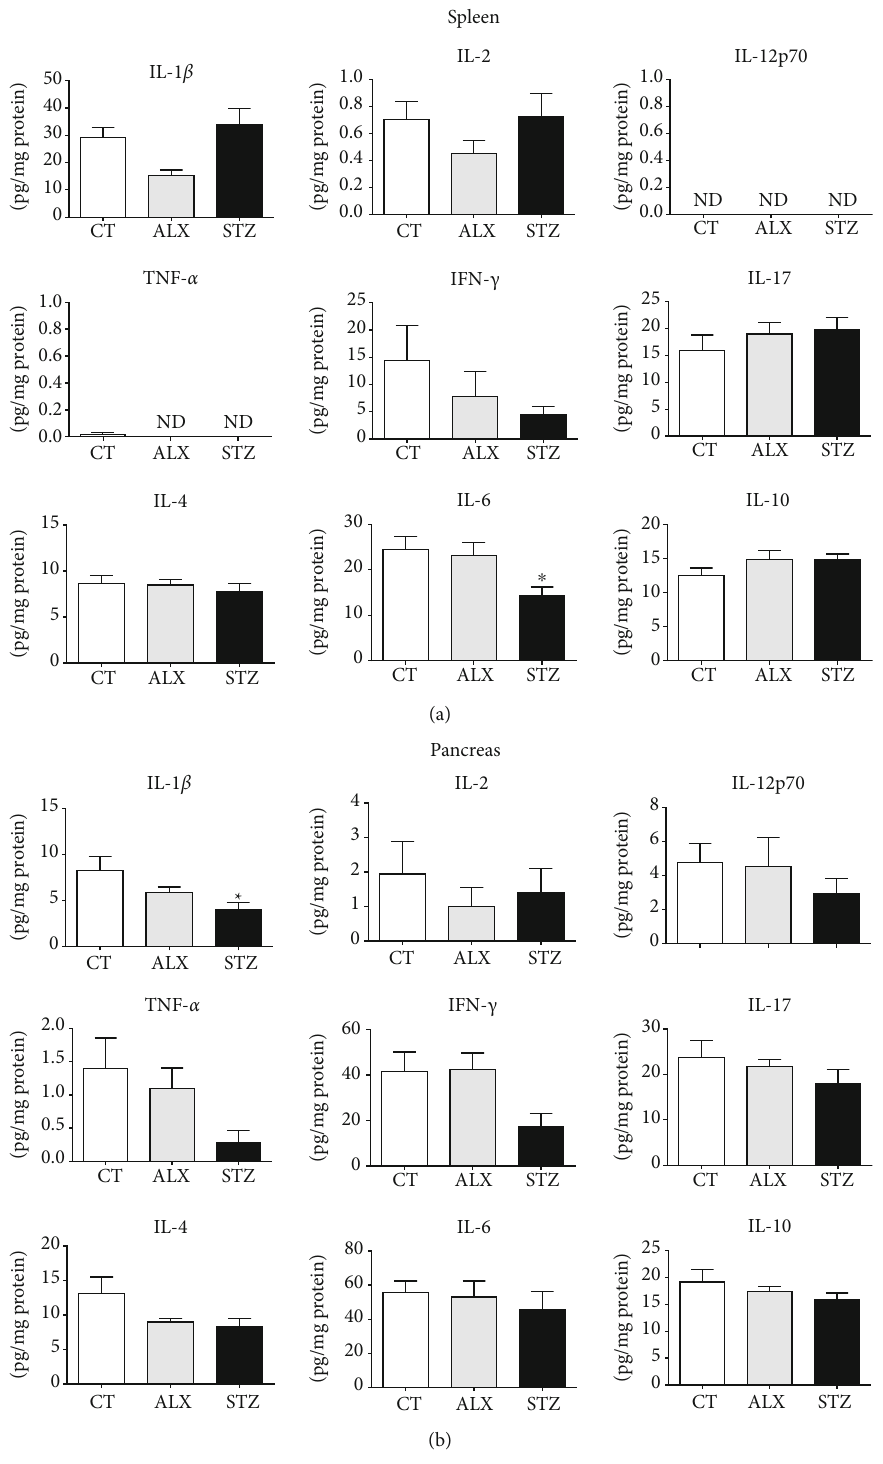
Figure 3: Short-term diabetogenic e ff ects of ALX and STZ on the basal levels of cytokines in spleen and pancreas homogenates. T1D was induced as described in Methods, and (a) spleens and (b) pancreases were collected on the 15 th day. Tissue homogenates from the CT, ALX-, and STZ-treated groups were evaluated for the presence of the cytokines IL-1 β , IL-2, IL-4, IL-6, IL-10, IL-12p70, IL-17, TNF- α , and IFN- γ . Data are presented as mean ± SEM , ∗ p ≤ 0 : 05 (5-6 animals per